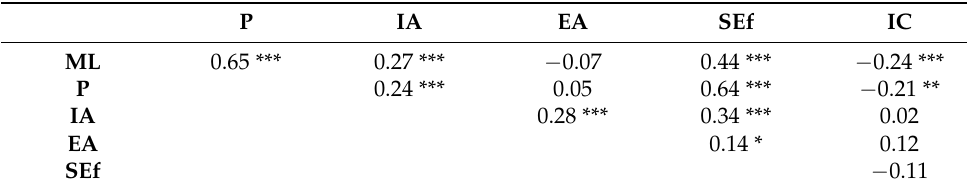
Table 1. Zero-order and partial correlations between